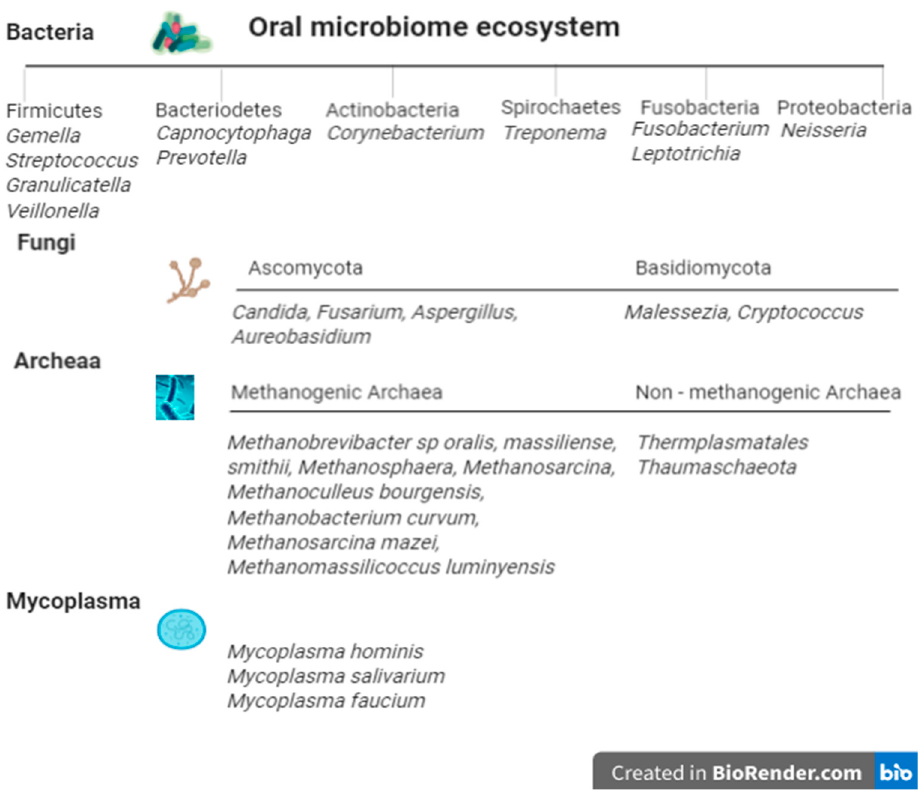
Figure 1. The oral microbiome ecosystem classification. References: [9 , 10,20,21].